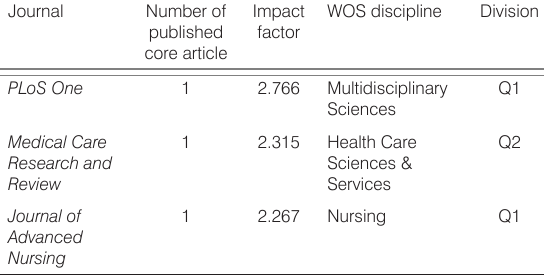
Table 1. Journal distribution of Research Frontier 1.